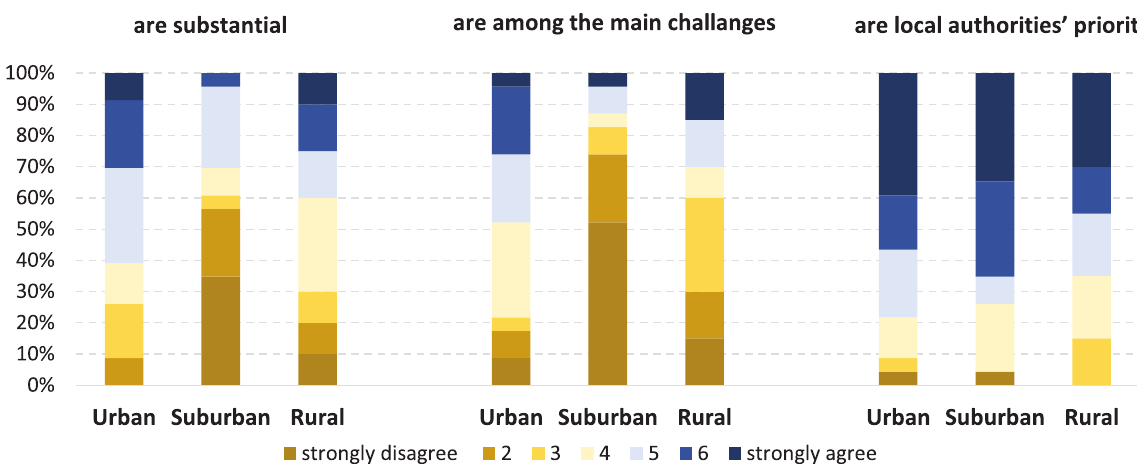
Figure 2. Perception of spatial inequalities at the local